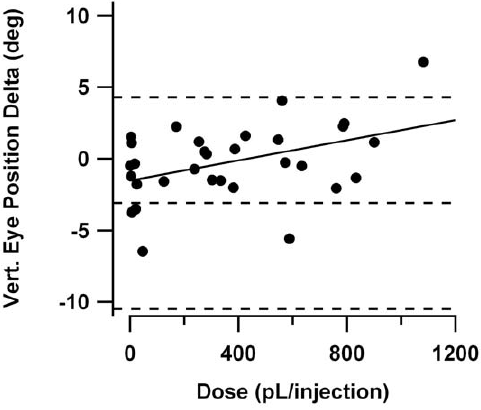
Figure 14. Change in vertical resting position of eye following intrafloccular 4-AP injections in tottering , plotted as a function of volume of each injection. Horizontal dashed lines indicate the mean and 6 2SD confidence interval for change in resting position in the systemic saline sessions of young tottering . Regression curve has been superimposed. There was a weak but significant trend for eye elevation to increase as a function of 4-AP dosage, consistent with 4-AP reducing mean Purkinje cell firing rate.